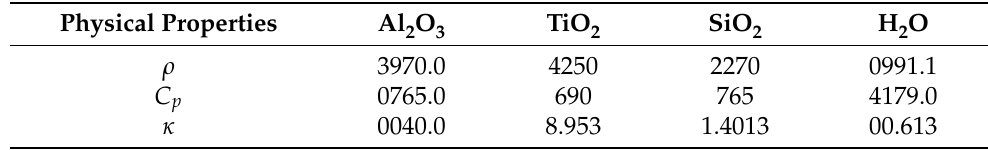
Table 1. Water and thermophysical properties of nanoparticles